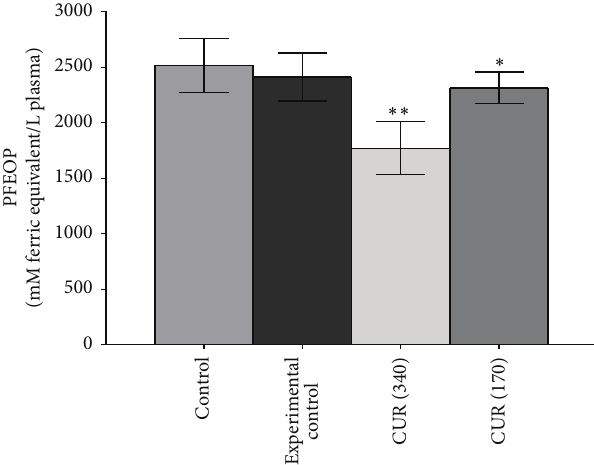
Figure 8: In vivo effect of curcumin (340 mg/kg b.w. as CUR 340 and 170 mg/kg b.w. oral CUR 170) on plasma oxidant potential of rat subjected. Plasma oxidant potential is expressed in mM ferric equiv- alent/L plasma. Values represent mean ± SD. Control represents rats receiving no treatment/supplementation; experimental control: rats were supplemented with 0.9% NaCl solution through oral